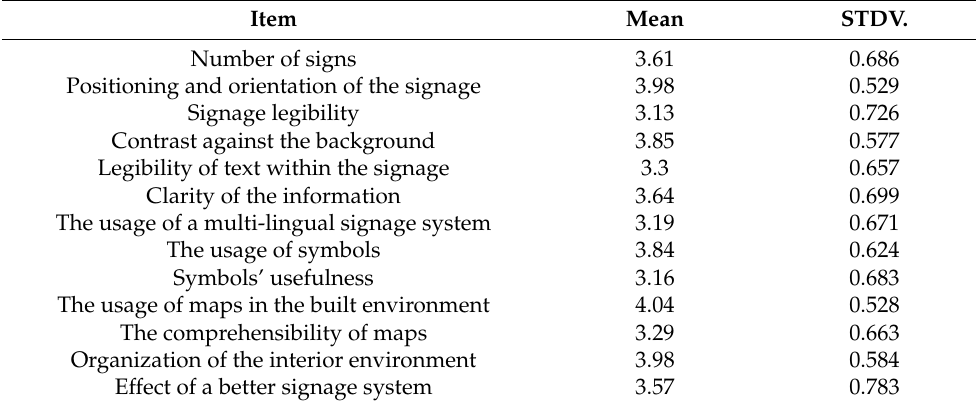
Table 2. Descriptive statistics of the responses to the environmental elements.